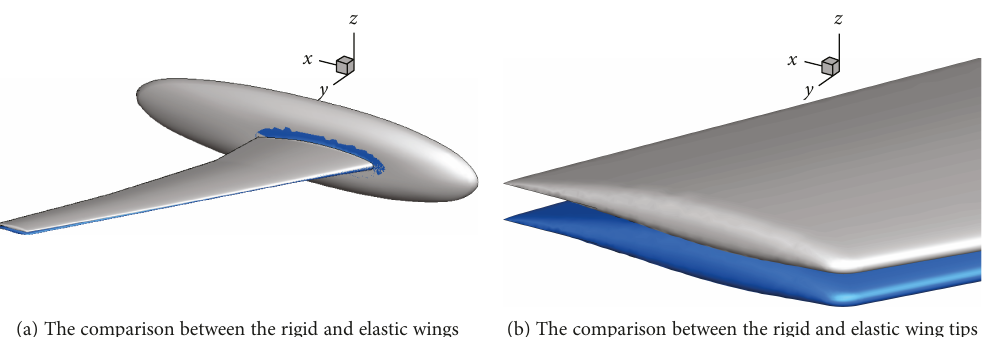
Figure 6: The de fl ection results of static aeroelasticity ( x streamwise, y : spanwise, z : height and blue: the rigid wing, white: the elastic wing).